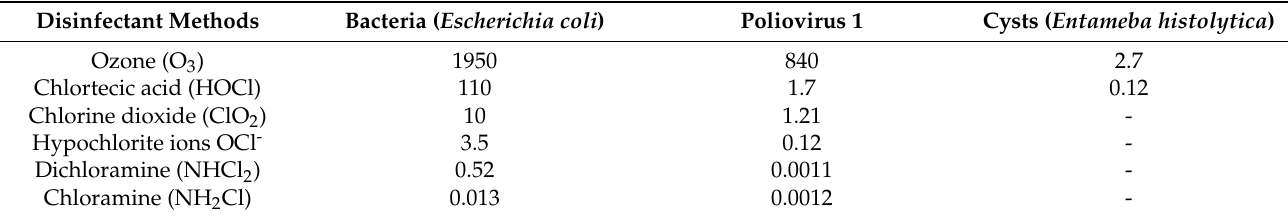
Figure 2. Technological process of destruction of harmful microorganisms in water: 1—compressor; 2—air drying device; 3—ozonator unit Etro-03; 4—water decontamination tank; 5—membrane filter.